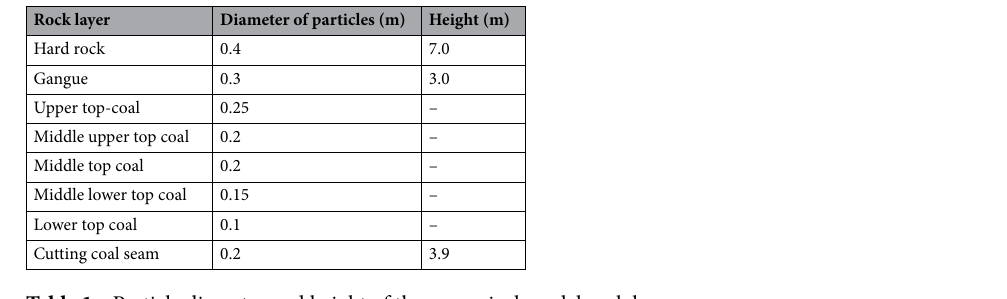
Table 1. Particle diameter and height of the numerical model rock layer.